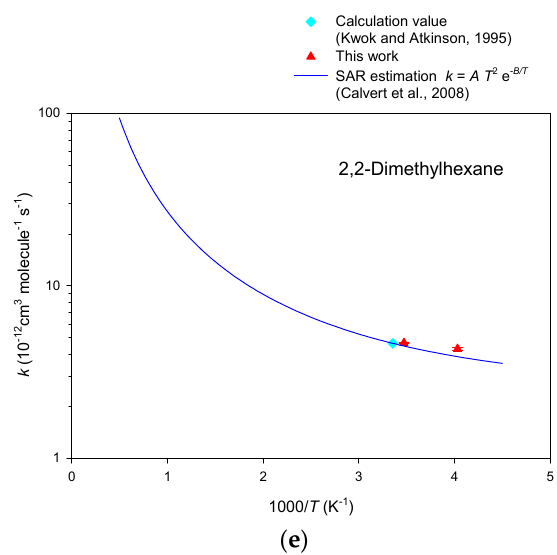
Figure 5. Arrhenius plots of the rate data for the reaction of OH radicals with branched-chain alkanes [47,53–58].